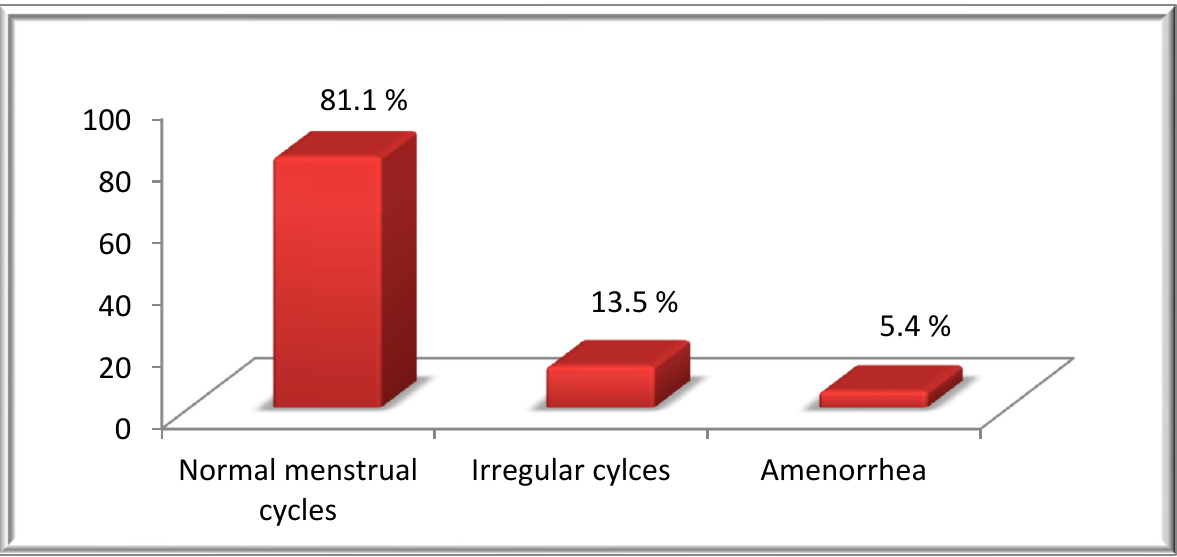
Figure 4. Distribution of HD patients according to menstrual status following ABVD treatment.